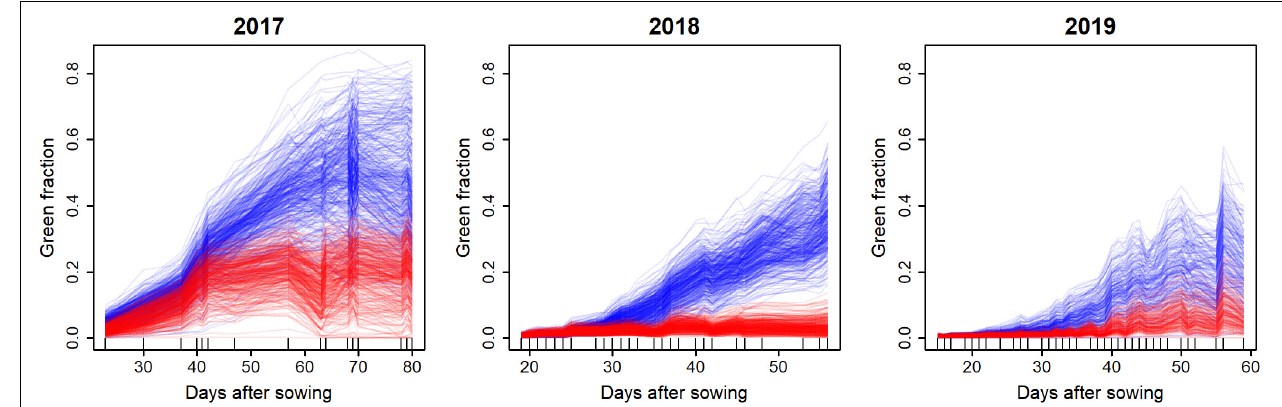
FIGURE 4 | Dynamics of the GF as observed from the UAV. Treatments C and D are shown with blue and red lines, respectively, each line corresponding to a plot. The number of days after sowing is used as the x-axis. Small vertical bars on x-axis indicate dates of